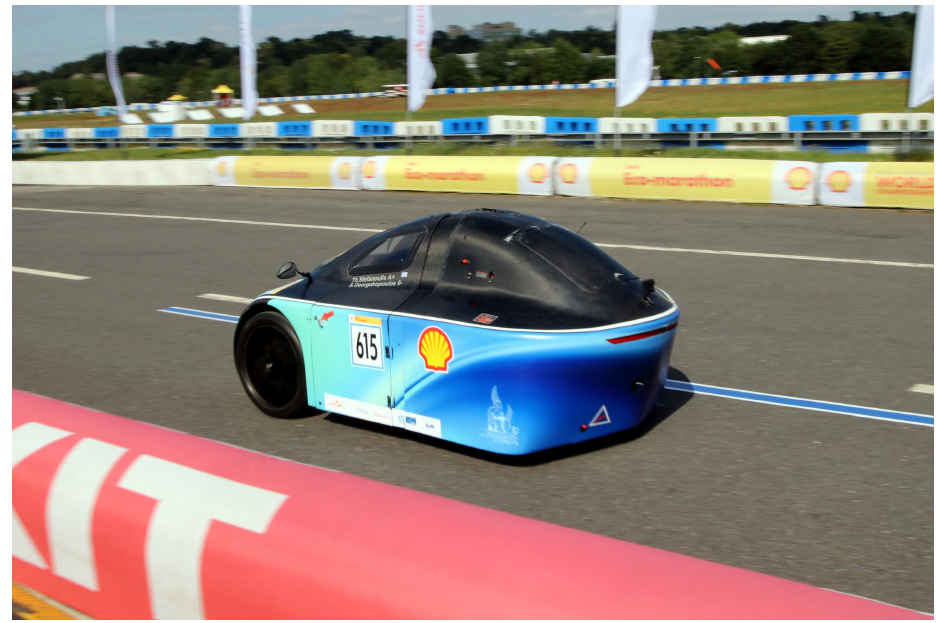
Figure 1. The prototype Spyros Louis at the Shell Eco Marathon Europe, London,